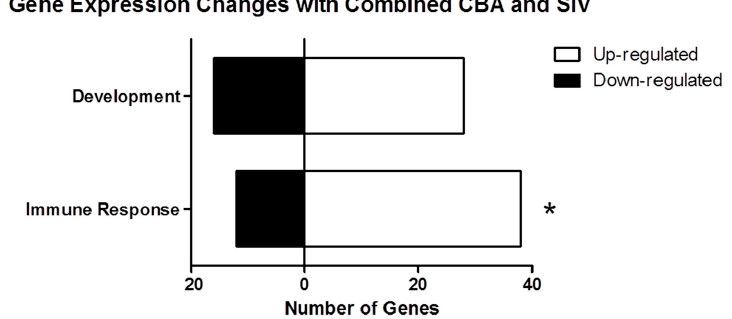
Figure 3. Number of genes involved in inflammatory and development processes that were up ‐ and down ‐ regulated. Immune processes include the set of genes from inflammation and immune response functions. The immune processes category had significantly more up ‐ regulated genes than expected (76%) compared to the total number of up ‐ regulated genes out of all differentially expressed genes (57%) (* p < 0.01, Chi ‐ square test). Table 2. Inflammation and immune response genes that are differentially expressed between CBA/SIV and SUC/SIV macaques. FC is the fold ‐ change in gene expression between CBA/SIV and SUC/SIV macaques.